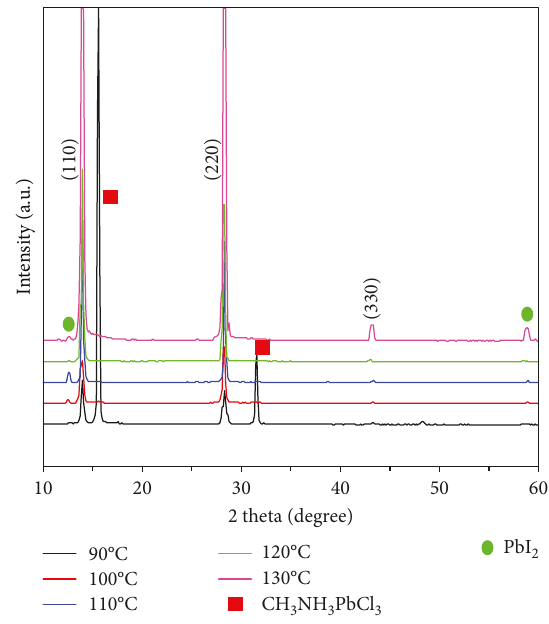
fi lms annealing at Figure 5: XRD patterns of CH NH PbI Cl 3 3 3-X X di ff erent OS direct annealing temperatures on TiO layers. The 2 red squares and green circles indicate the peaks associated with the CH NH PbCl and PbI , 3 3 3 2